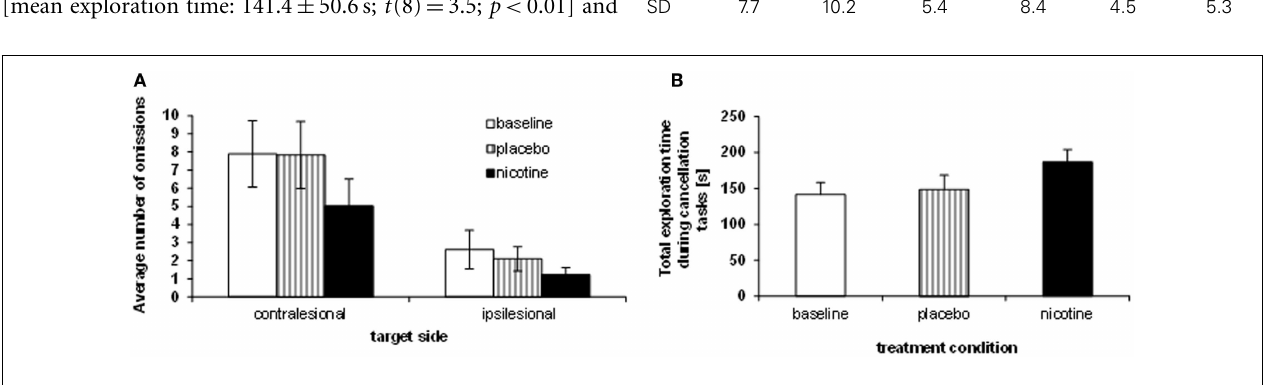
time, across the three cancellation tasks (millisecond), showing longer search periods under nicotine as opposed to placebo and baseline